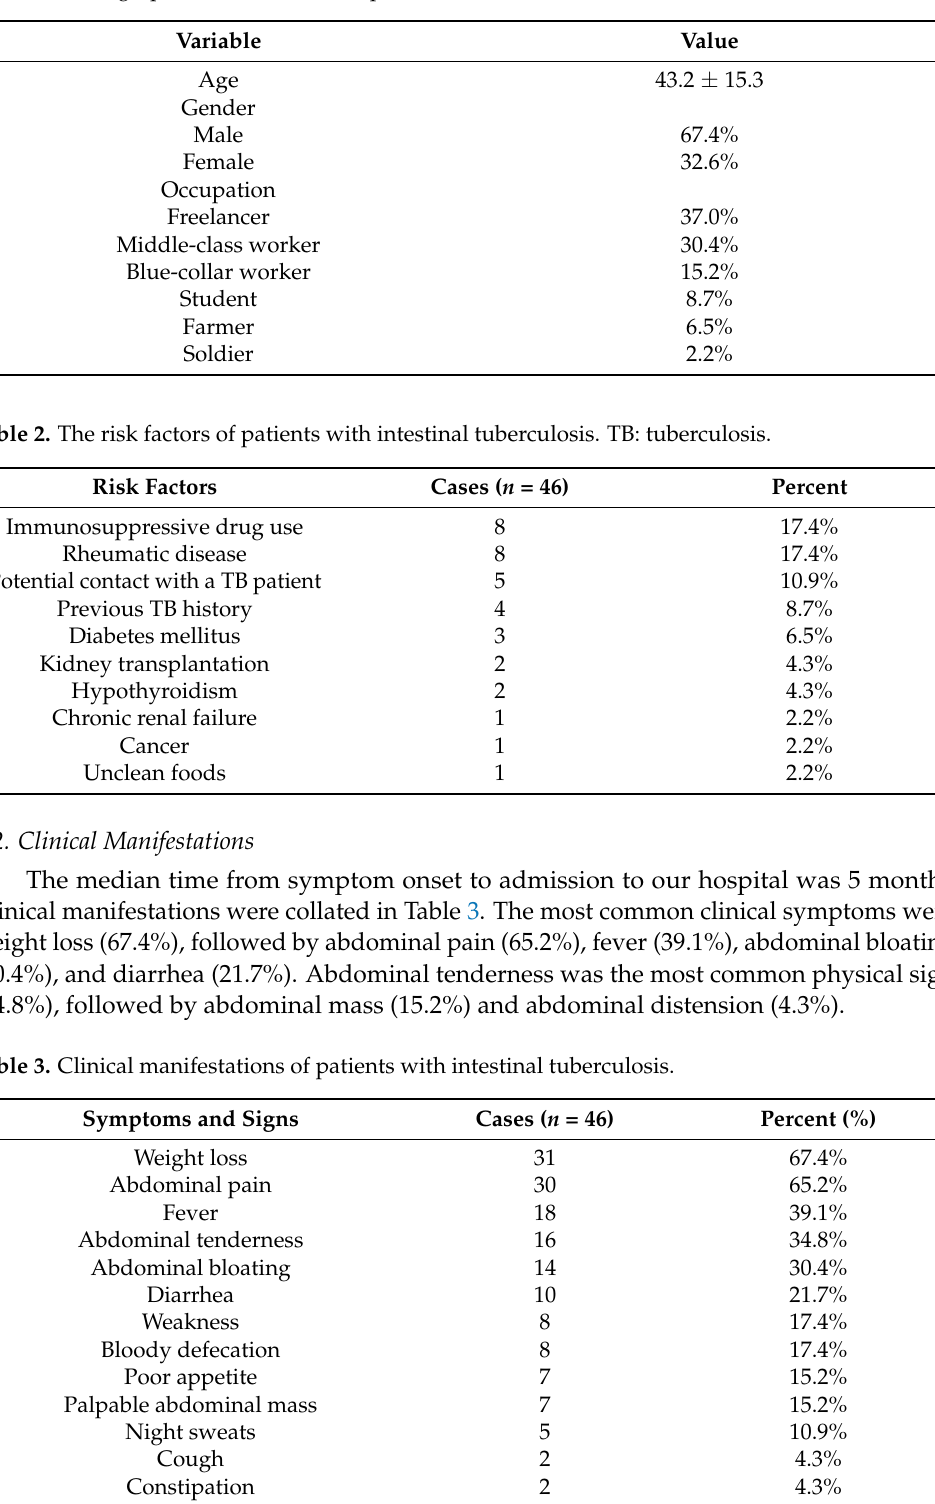
Table 1. Demographic characteristics of patients with intestinal tuberculosis.